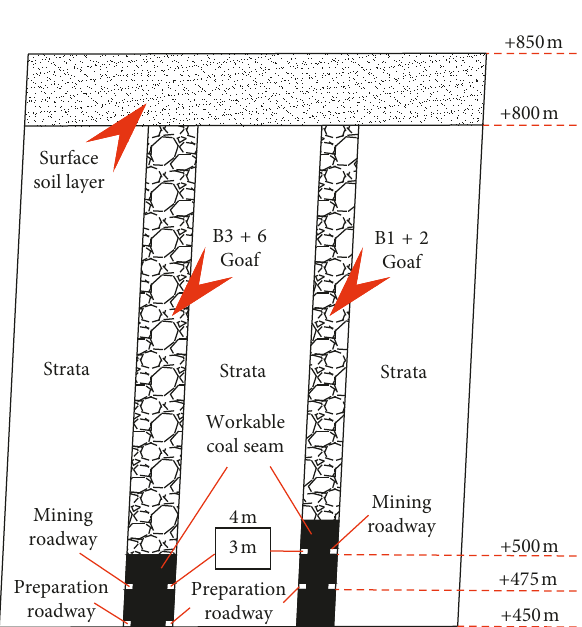
Figure 12: Mining arrangement in Wudong mine in